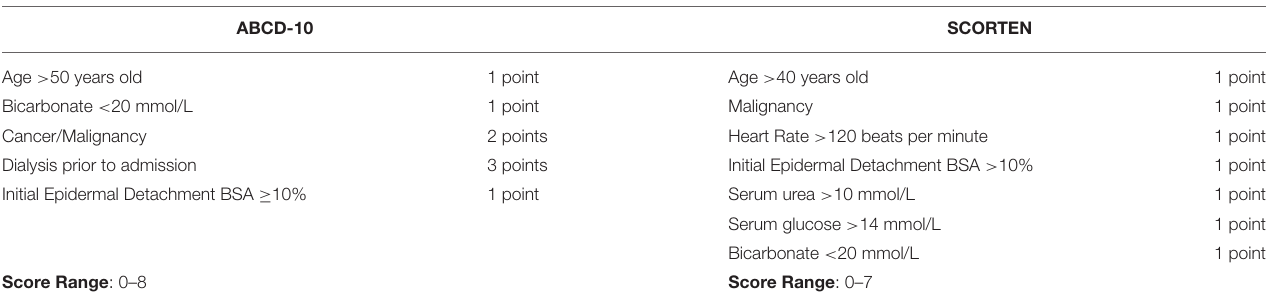
TABLE 1 | Comparison of mortality prognostic tools ABCD-10 and